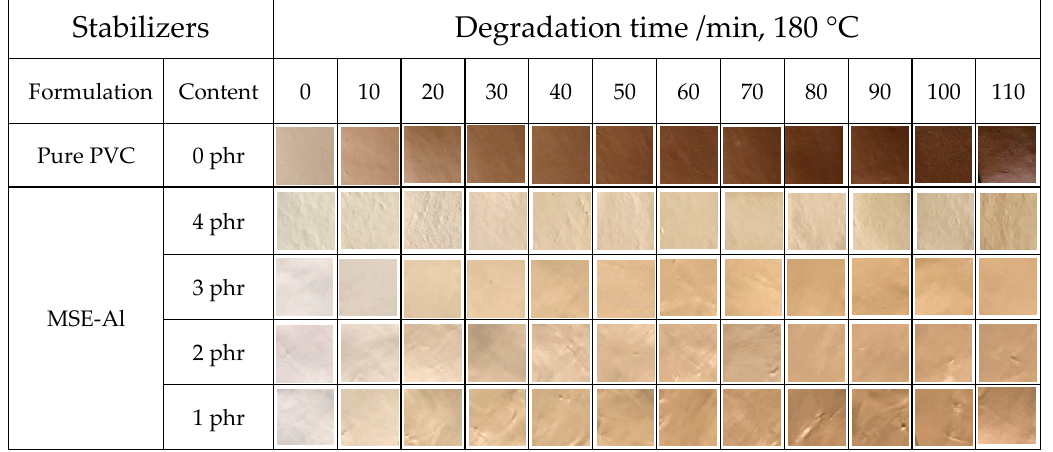
Figure 4. Thermal aging test of PVC samples stabilized with different amounts of MSE-Al.